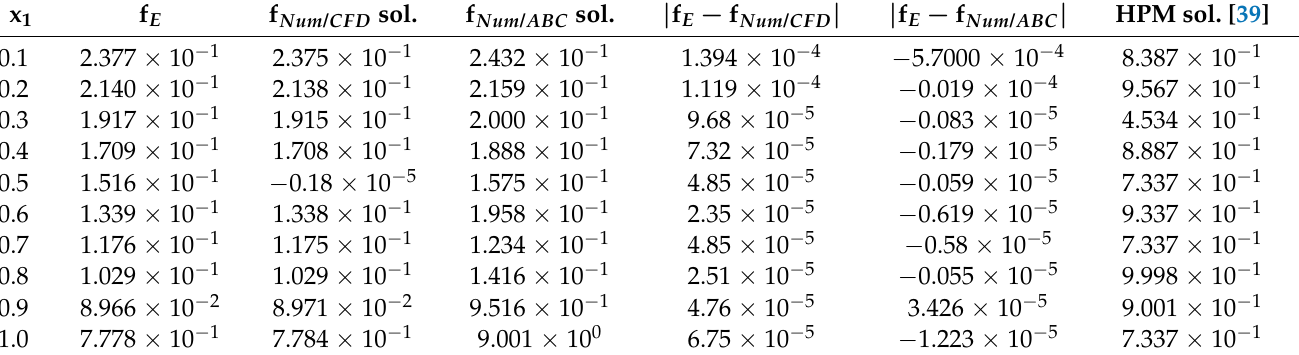
Table 2. Comparison results with exact ( f E ) IETM-numerical solutions ( f Num ) for CFD and ABC fractional derivative operator of f ( x 1 , ¯ t ) of Case 2 with absolute errors and the HPM [39] when α = 1, ¯ t = 0.01, and ϕ = 0 for various values of x 1 .